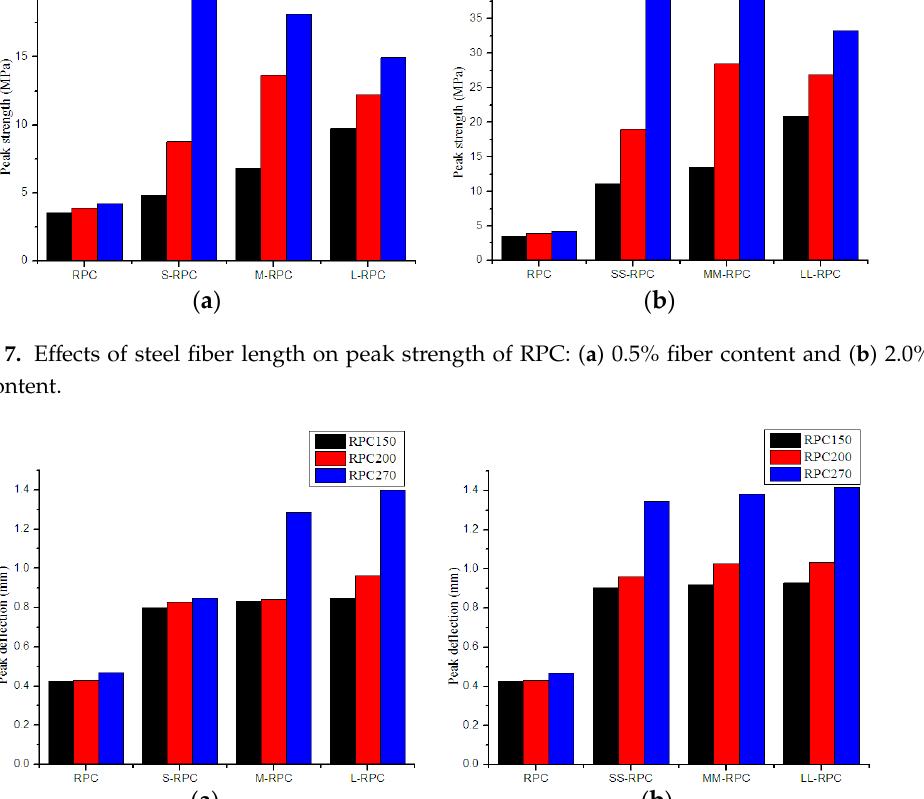
( b ) Figure 9. Effects of steel fiber length on the toughness index I 20 of RPC: ( a ) 0.5% fiber content and ( b ) 2.0% fiber content. 4. Discussion 4.1. Mechanism of Fiber Reinforcement The destruction process of concrete structures comprises the initiation, growth, and coalesces of microcracks, until macrocracks appear and finally produce failure. The main function of fiber